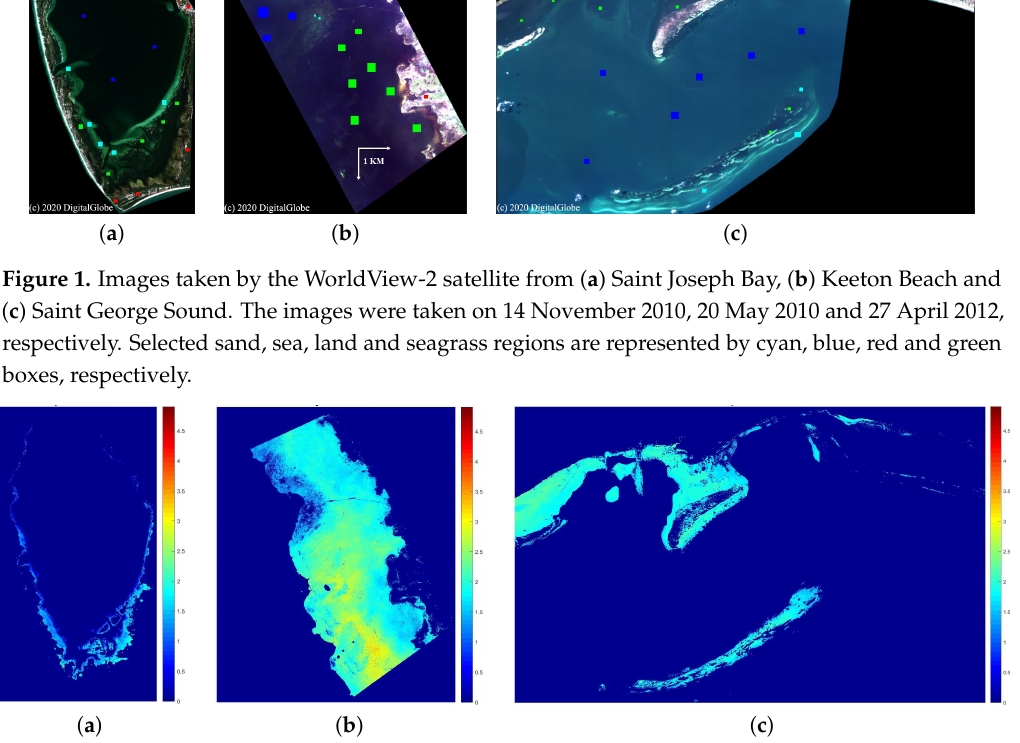
Figure 2. Mappings of seagrass LAI level obtained by the physics model [4] at ( a ) Saint Joseph Bay, ( b ) Keeton Beach and ( c ) Saint George